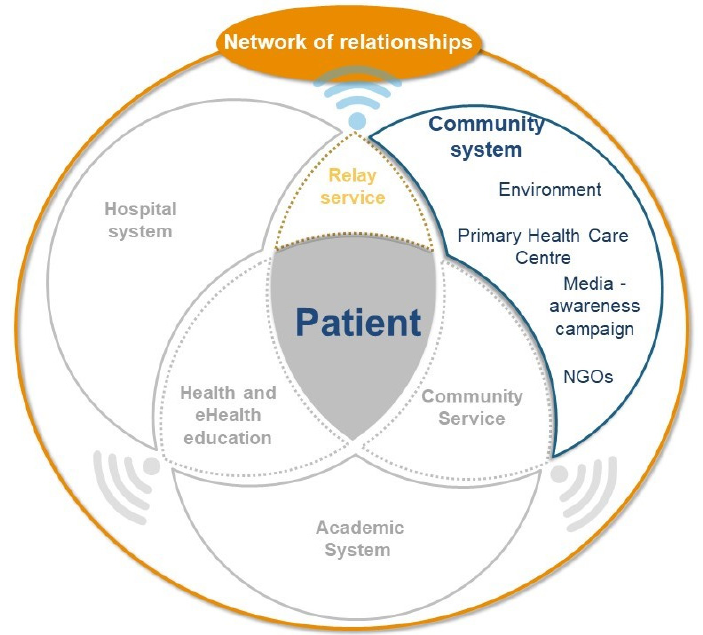
Figure 3. Community